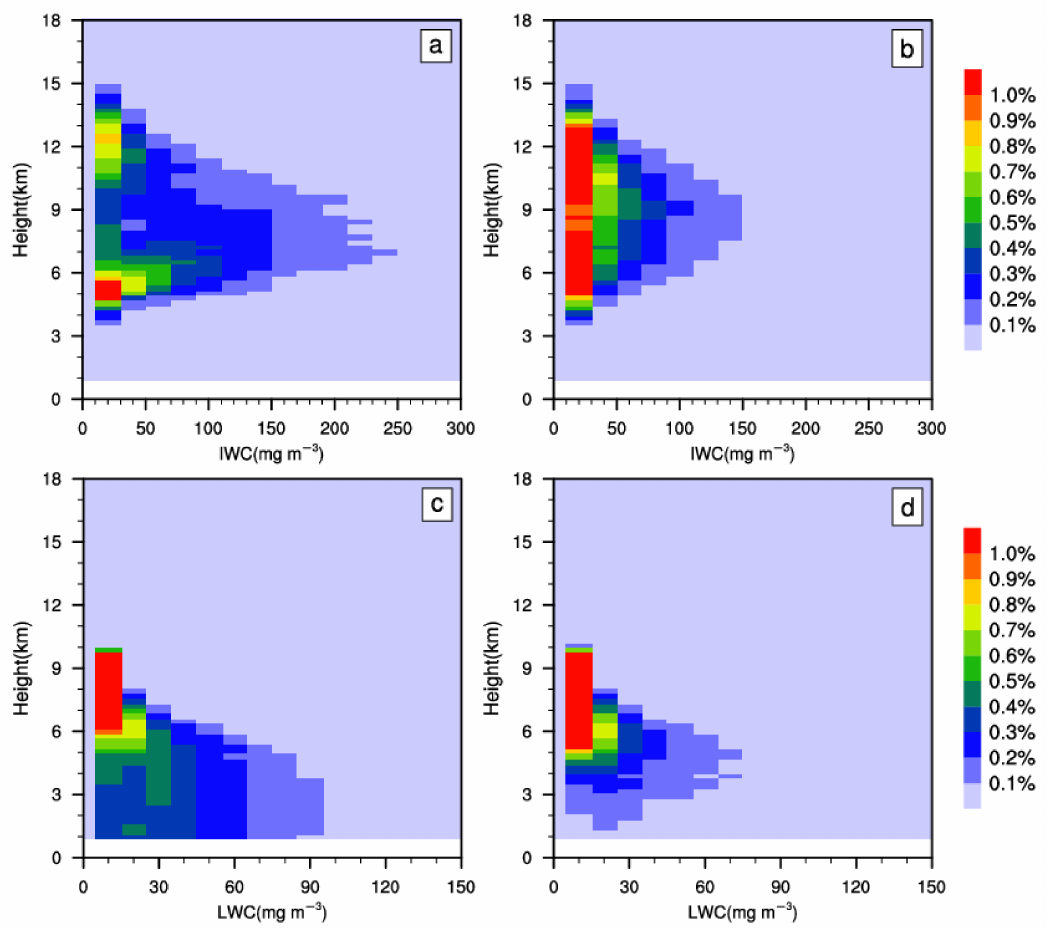
Figure 8. Normalized contoured frequency by altitude diagrams for the ice water content and liquid water content for ( a , c ) precipitating clouds and ( b , d ) non-precipitating